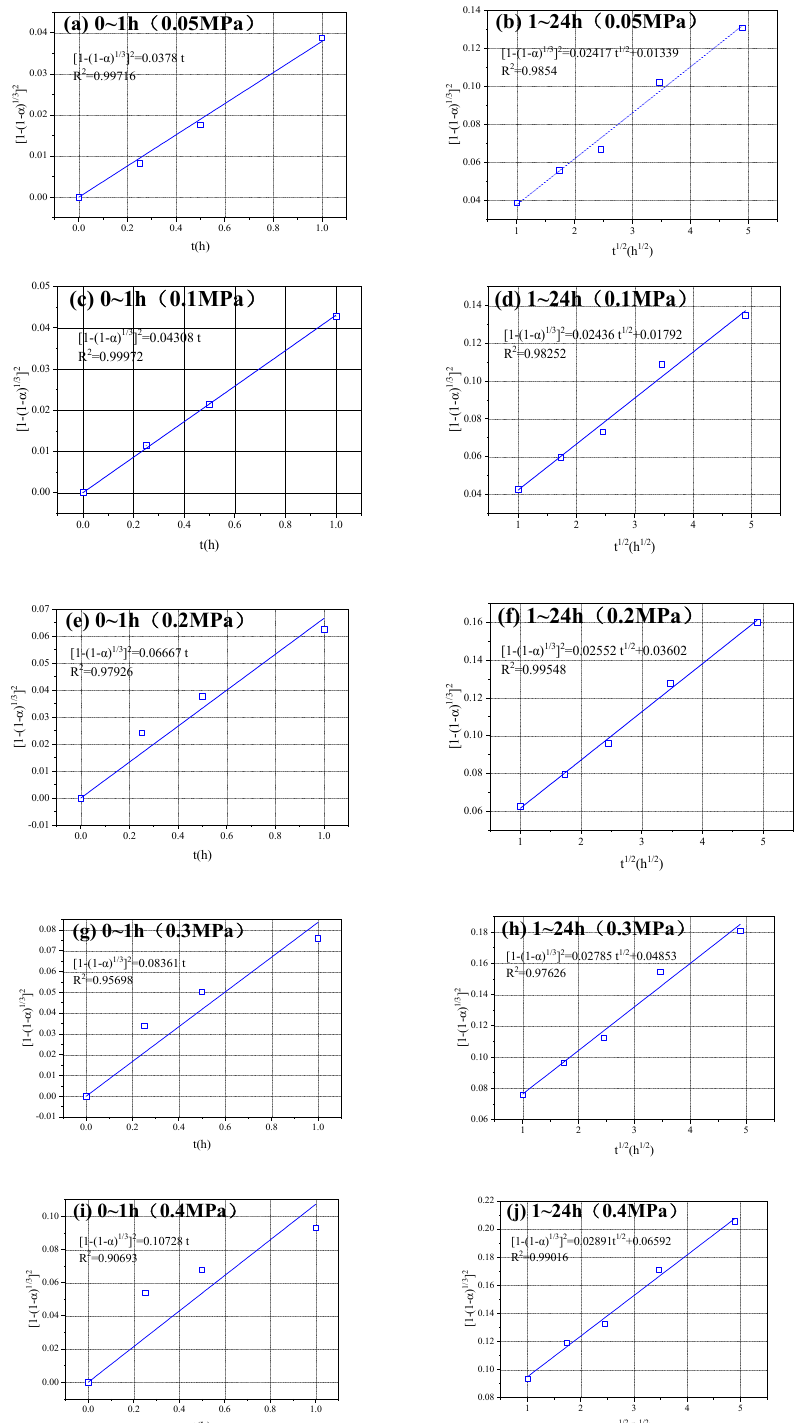
Figure 7. Linear-regression analysis under varying CO 2 pressure.